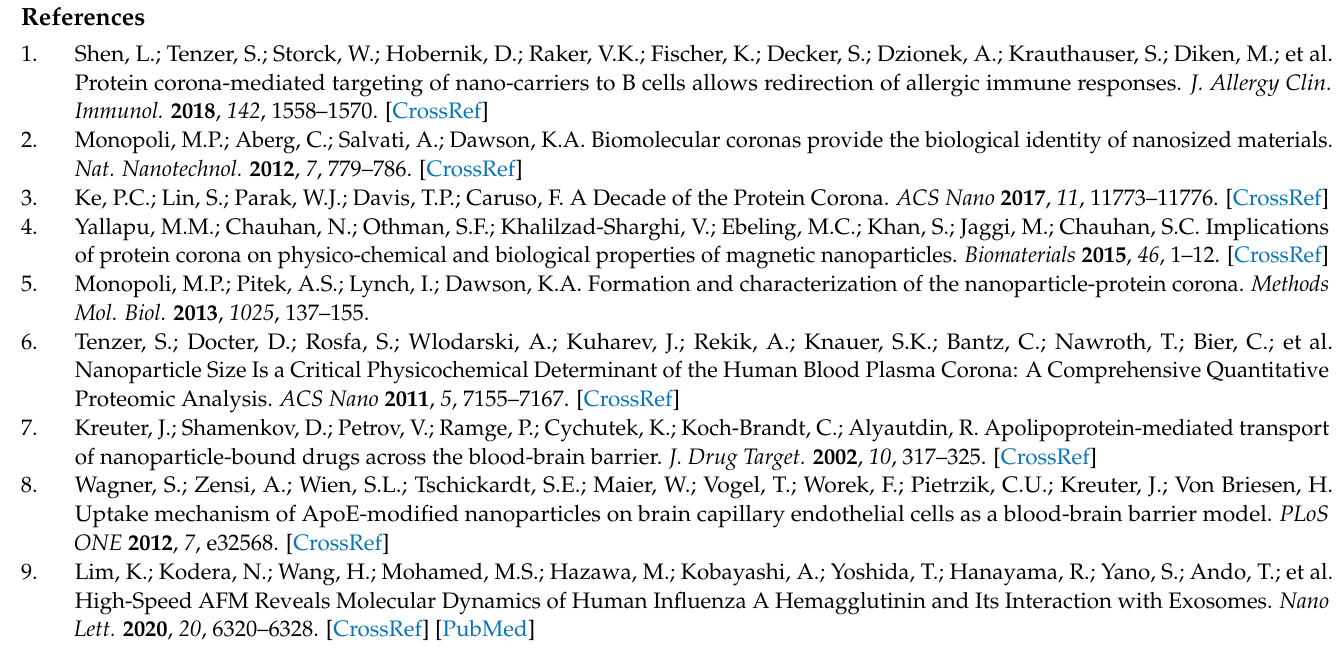
Figure S4: mgHES nanoparticles were injected into mice, the blood was isolated after distinct time points (A = 1 min, B = 1 h) and nanoparticles were recovered via magnetic separation, Figure S5: To mimic in vivo corona formation, nanoparticles were incubated directly in blood (ex vivo) for 1 min, Table S1: P values for all corona proteins shown in Figure